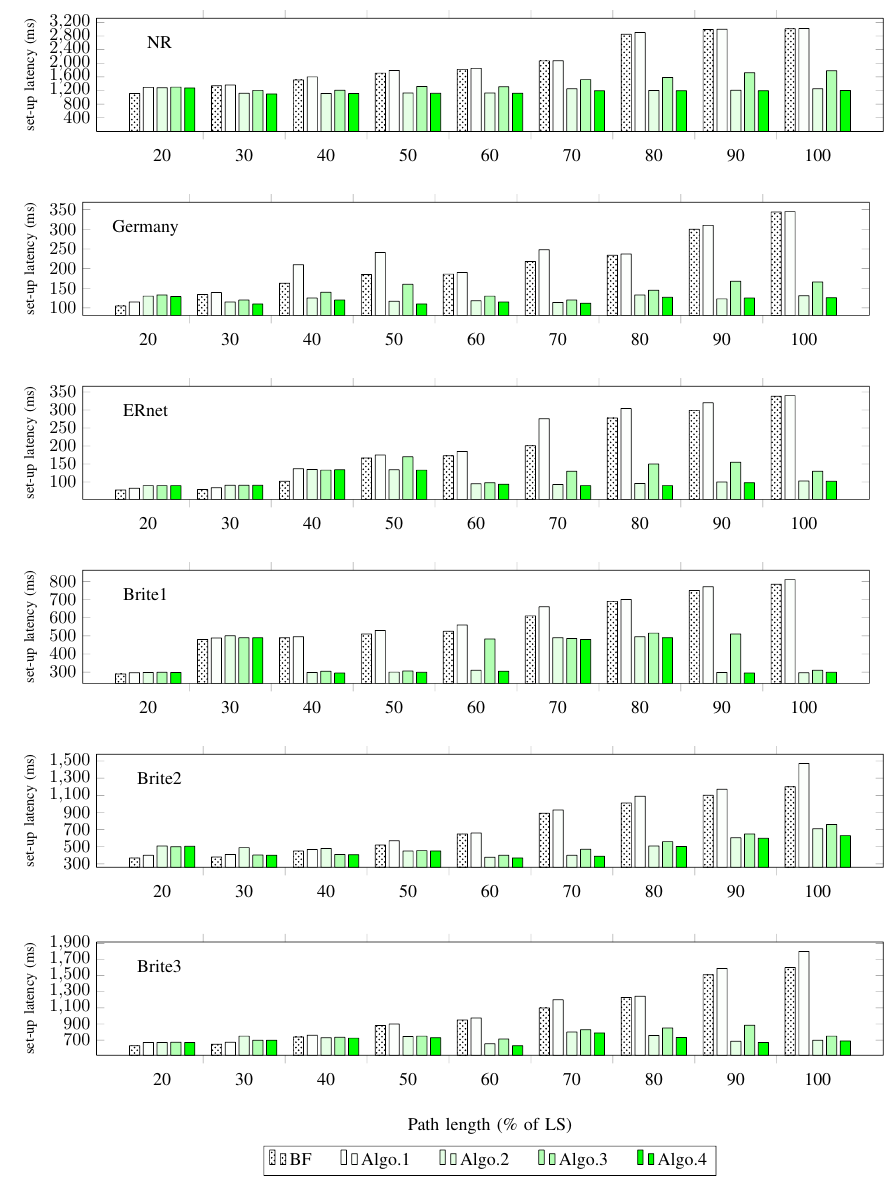
Fig. 10. Path set-up latency versus path length of the experimental topologies The path set-up latency, i.e. time required to install the network path, achieved Figure 10. The path set-up latency, that is, time required to install the network path, achieved by by Algorithms 1, 2, 3 and 4 for the experimental topologies of Table I Algorithms 1–4 for the experimental topologies of Table 1 are illustrated as a function of the normalized path